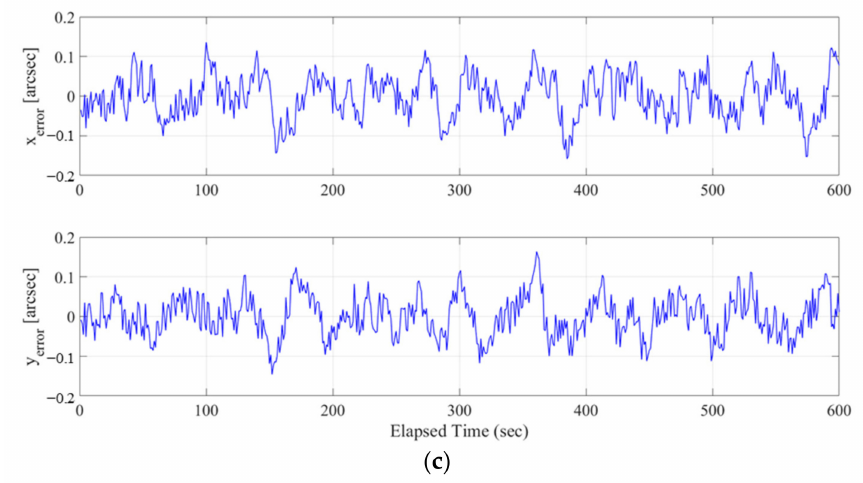
Figure 13. Preliminary Matlab/Simulink analysis results for the PSD in frequency domain and errors in time-series according to the FSM tip-tilt control to reject jitters in the fine PAT stage: ( a ) x-axis (roll axis of the bus); ( b ) y-axis (pitch axis of the bus); ( c ) residual jitters in time-series with FSM controls.